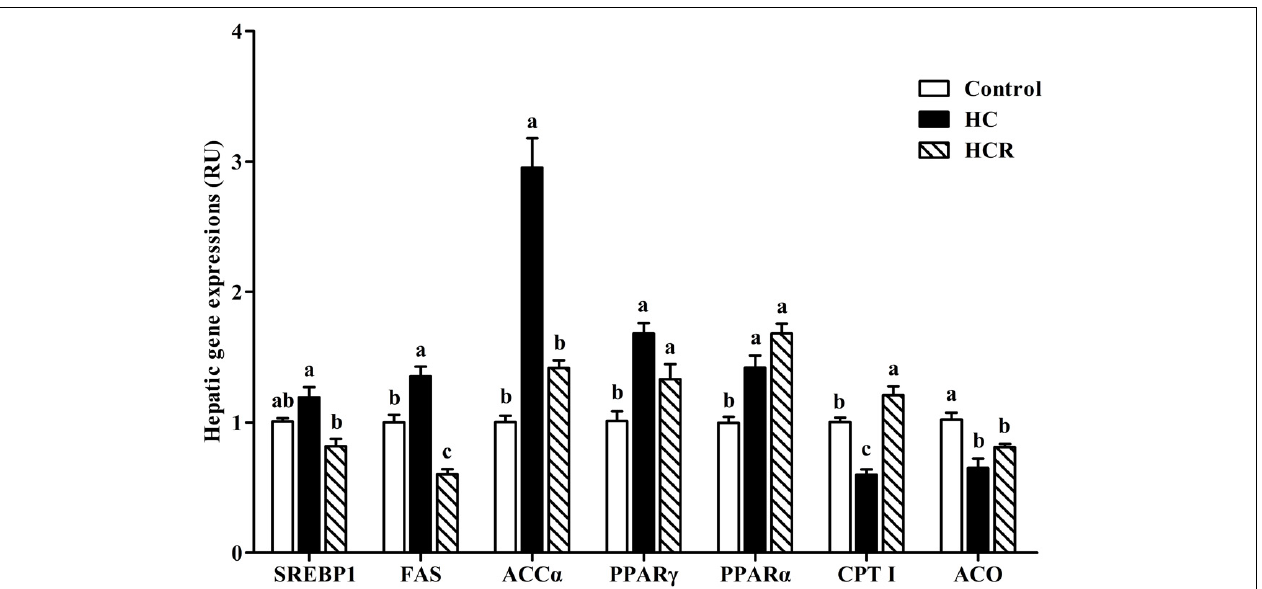
FIGURE 5 | Relative expressions of the genes involved in lipid metabolism in the liver of blunt snout bream fed different experimental diets. Data are referred to the values (relative units, RU) obtained in fish fed the control diet. Values were normalized with the transcription of EF1 α . Each data represents the mean of four replicates. Bars assigned with different letters are significantly different ( P < 0.05). Control, diet with 30% carbohydrate level; HC, diet with 41% carbohydrate level; HCR, diet with 41% carbohydrate and 0.04% resveratrol.